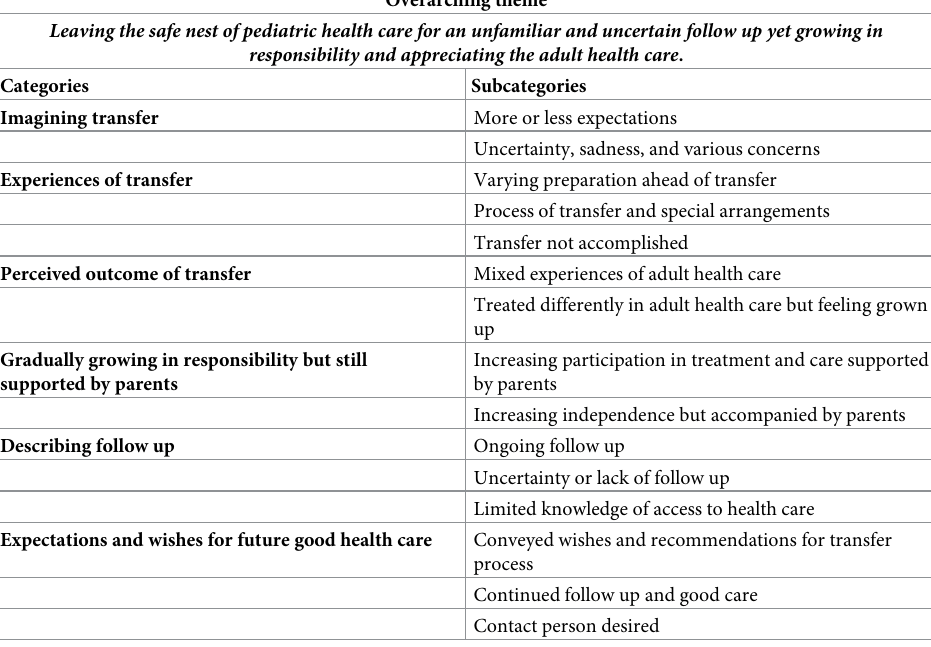
Table 2. Overarching theme, categories, and subcategories describing expectations, concerns, and experiences in conjunction with transfer to adult health care. Overarching